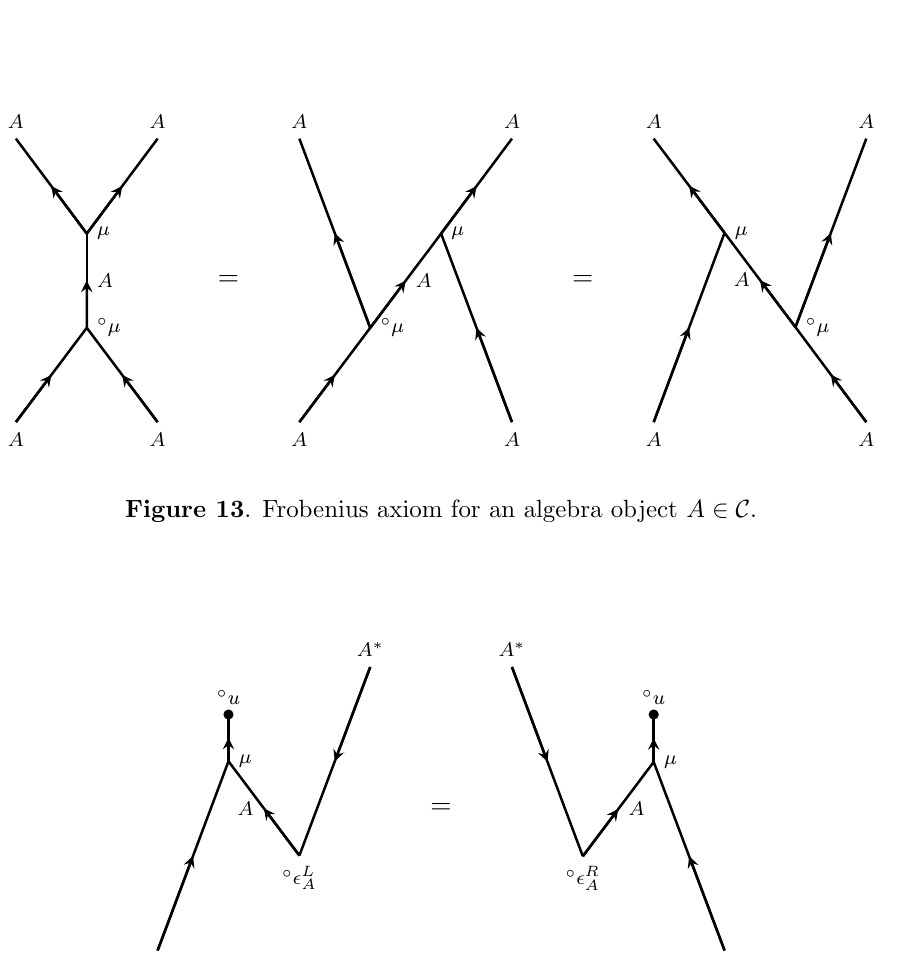
Figure 12 . Separability axiom for an algebra object A 2 C .